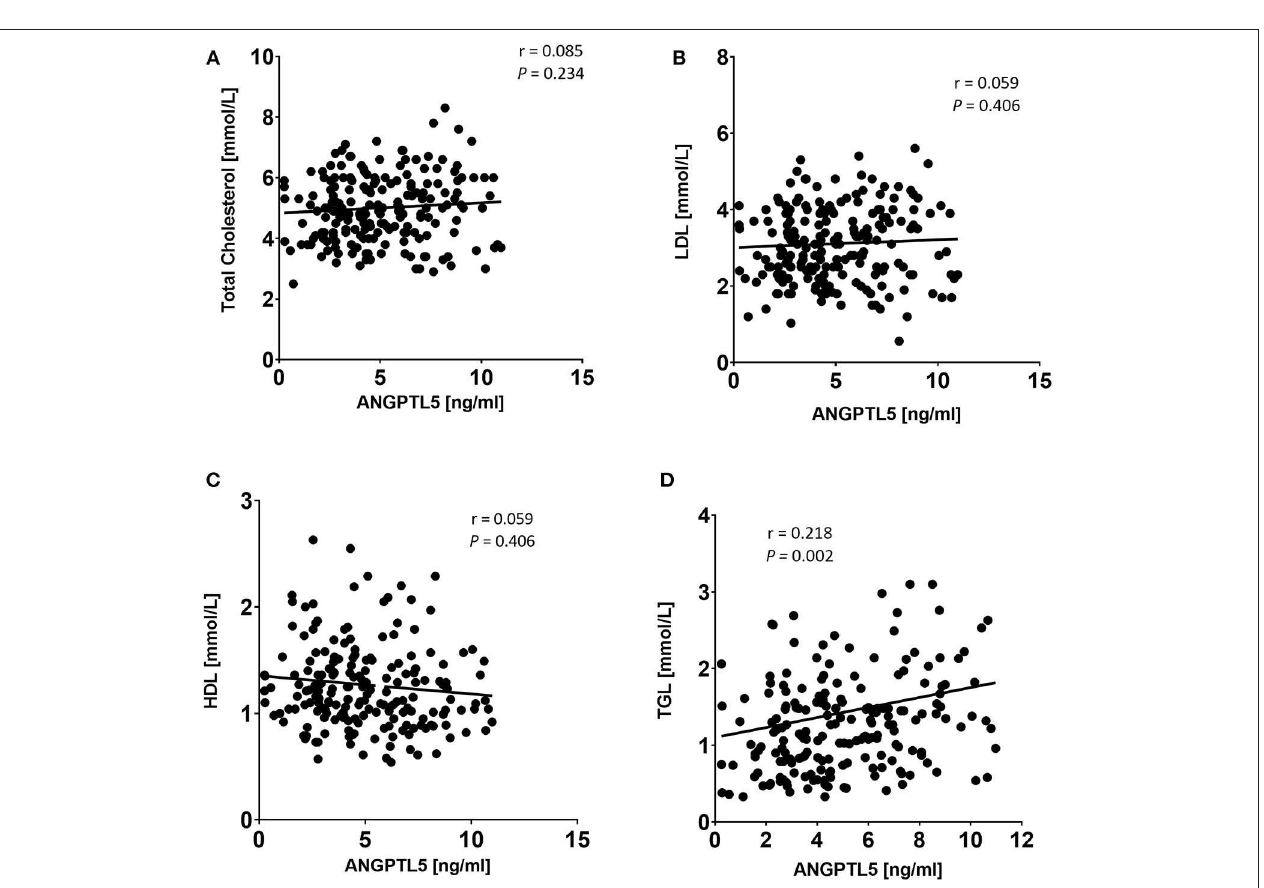
FIGURE 6 | Spearman’s correlation analysis of ANGPTL5 levels and TC (A) , LDL (B) , HDL (C) , and TGL (D) . P < 0.05 was considered significant as determined by Spearman’s